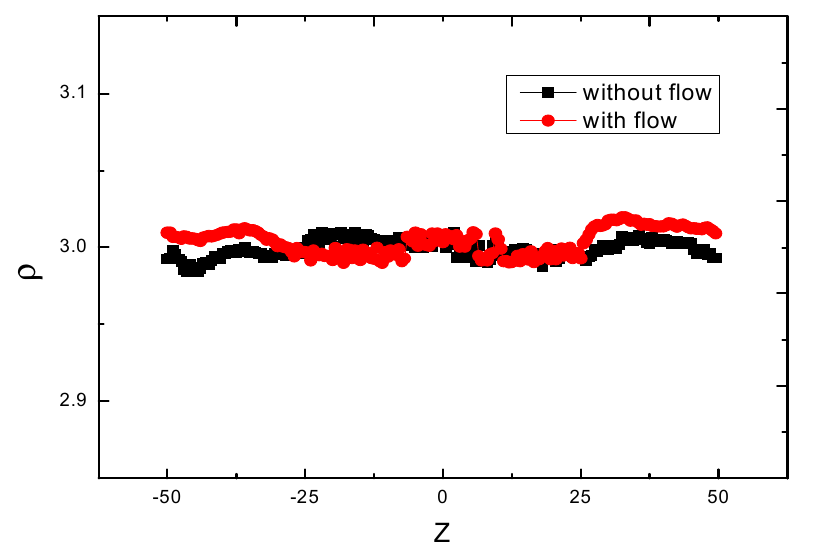
Figure 3. Solvent particle density profiles along the z − axis direction of the Poiseuille flow, the square symbols indicate that there is no flow rate added, and the circle symbols represents that there is flow rate added.